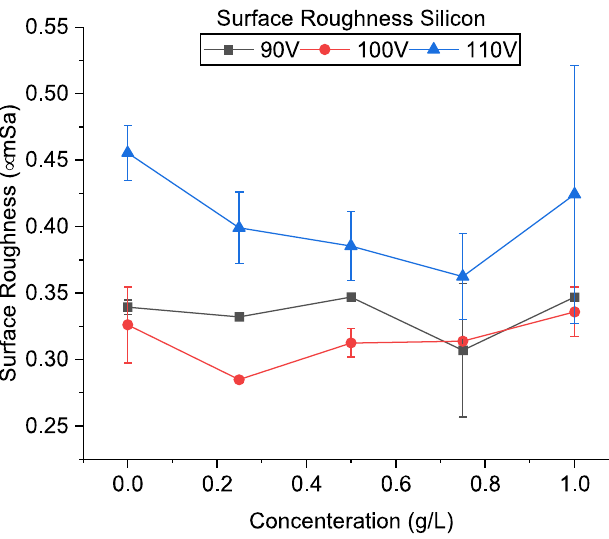
Figure 22. Surface roughness using silicon-mixed